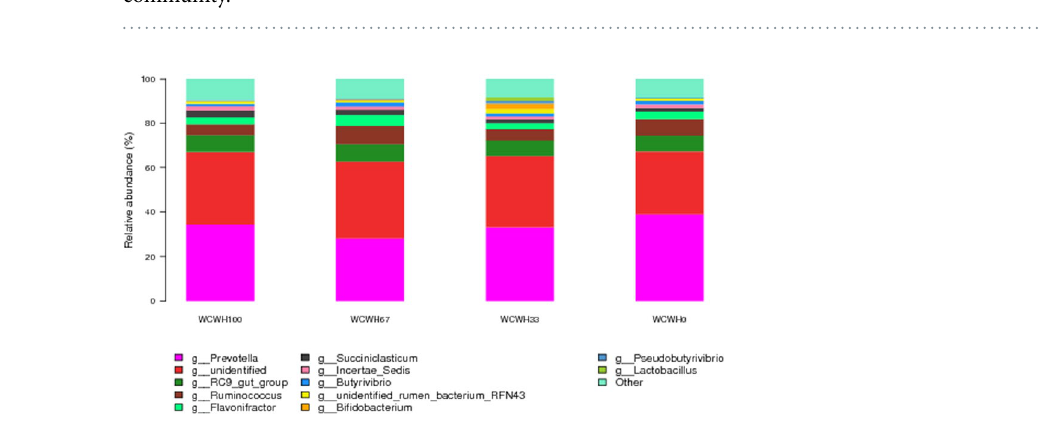
Figure 3. The effects of dietary treatments on the relative abundance of phyla in the ruminal bacterial community.